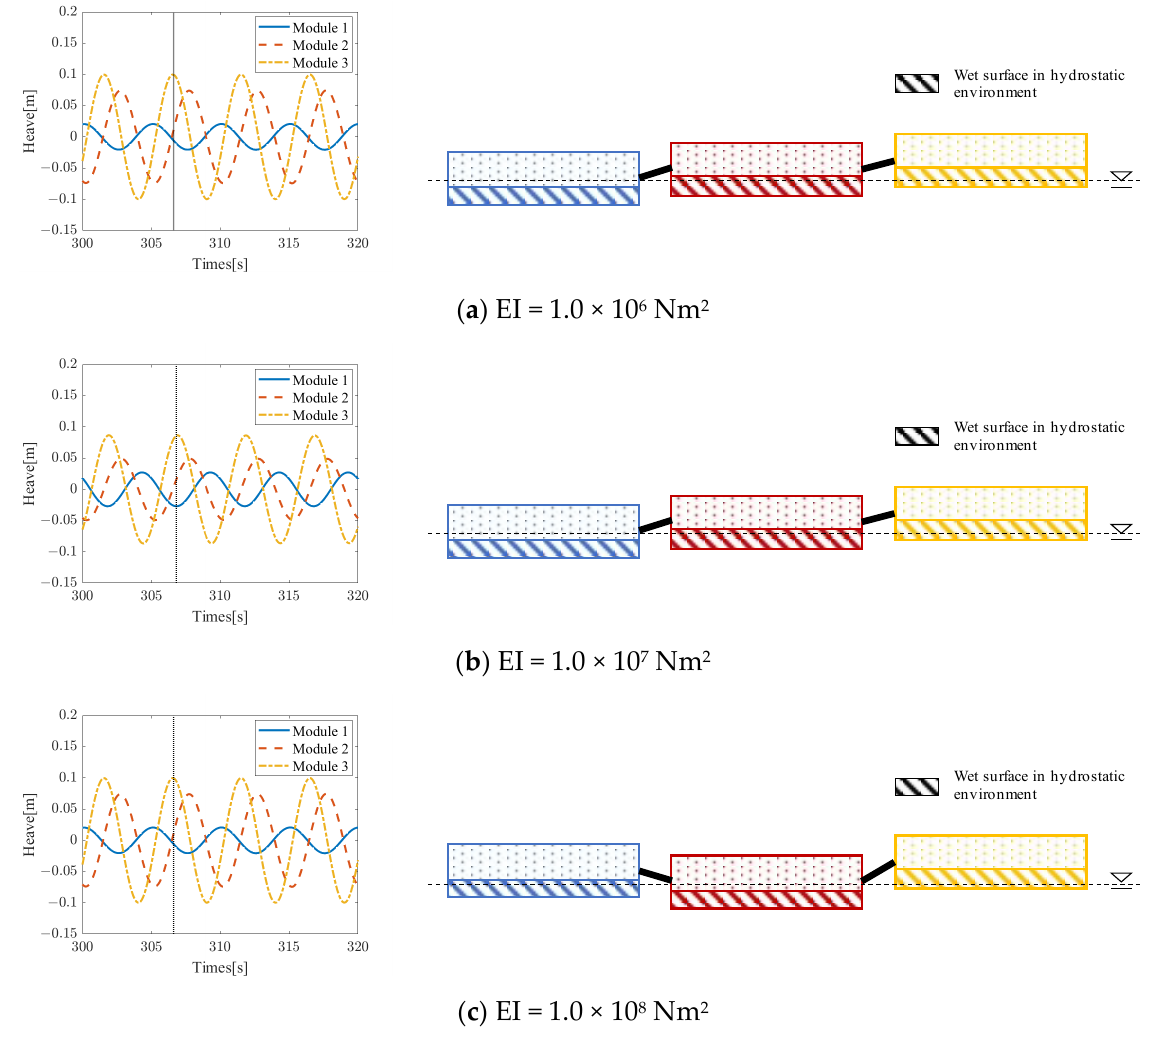
Figure 13. The system's instantaneous motion state under different connector stiffness when the windward module’s heave motion is at the peak at ω = 1.26 rad/s and wave amplitude of 2 m in a head sea.